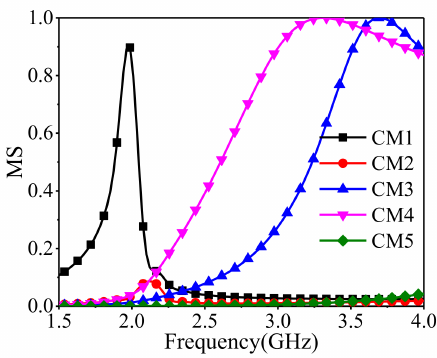
Figure 3. Modal significances of the folding-line slot antenna.